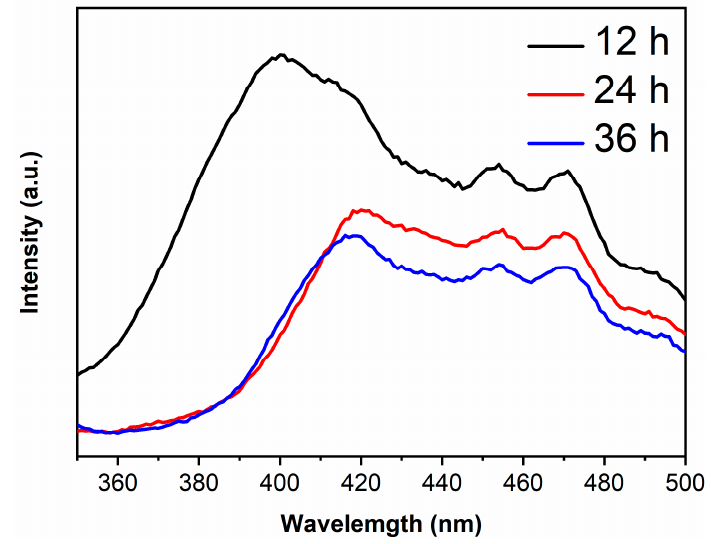
Figure 6. The PL spectra of TiO 2 -12 h, TiO 2 -24 h and TiO 2 -36 h.